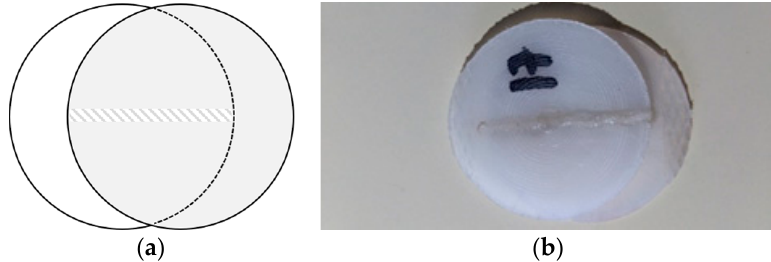
Figure 1. Longitudinal overlap joint configuration: ( a ) Illustration; ( b ) Welded sample.